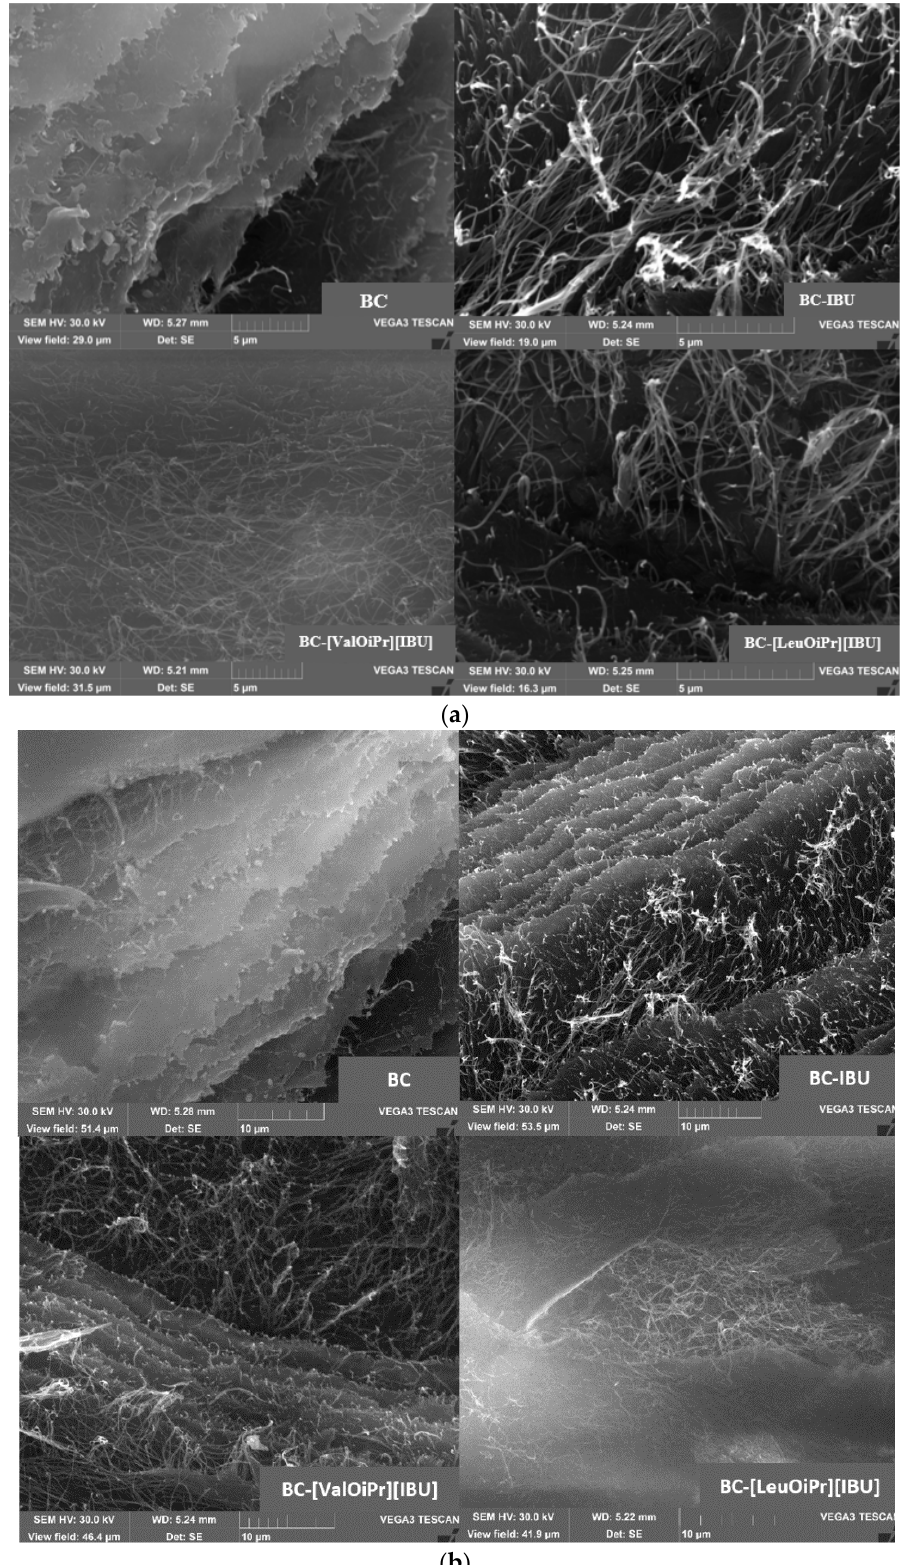
Figure 2. SEM images of BC, BC-IBU, BC-[ValOiPr][IBU] and BC-[LeuOiPr][IBU] ( a ) Scale of 5 μ m ( b ) Scale of 10 μ m.